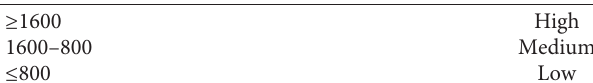
Table 2: Win score (Ca x PTH).